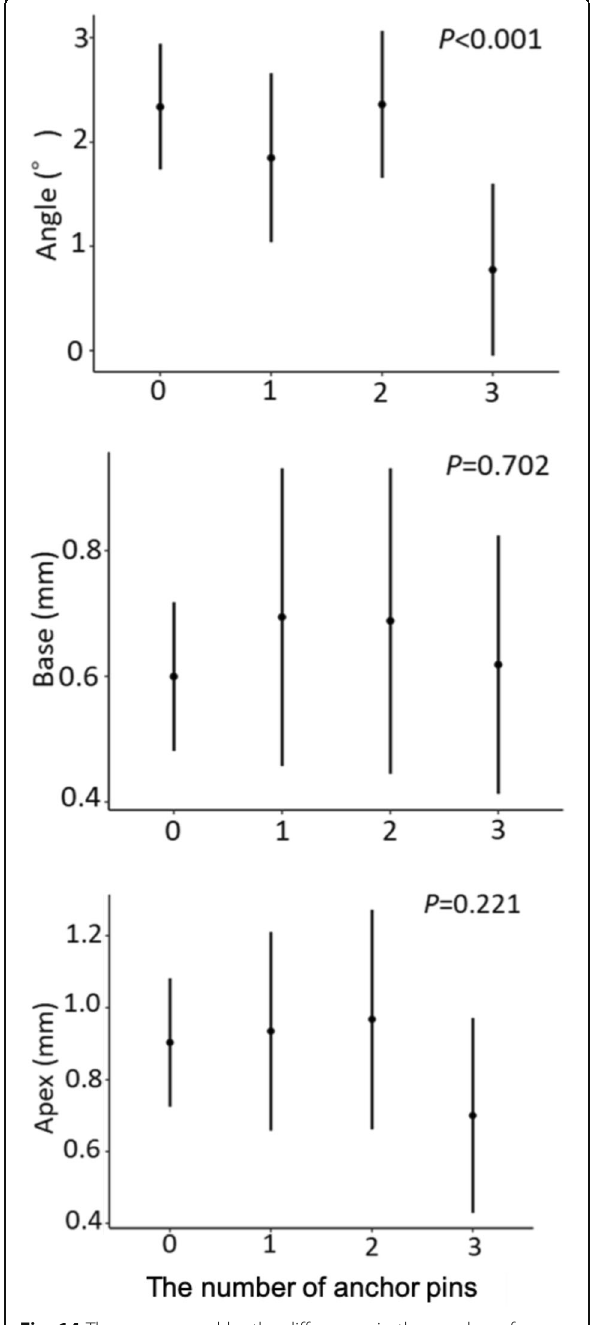
Fig. 14 The error caused by the differences in the number of anchor pins. Error bars indicate 95% confidence intervals